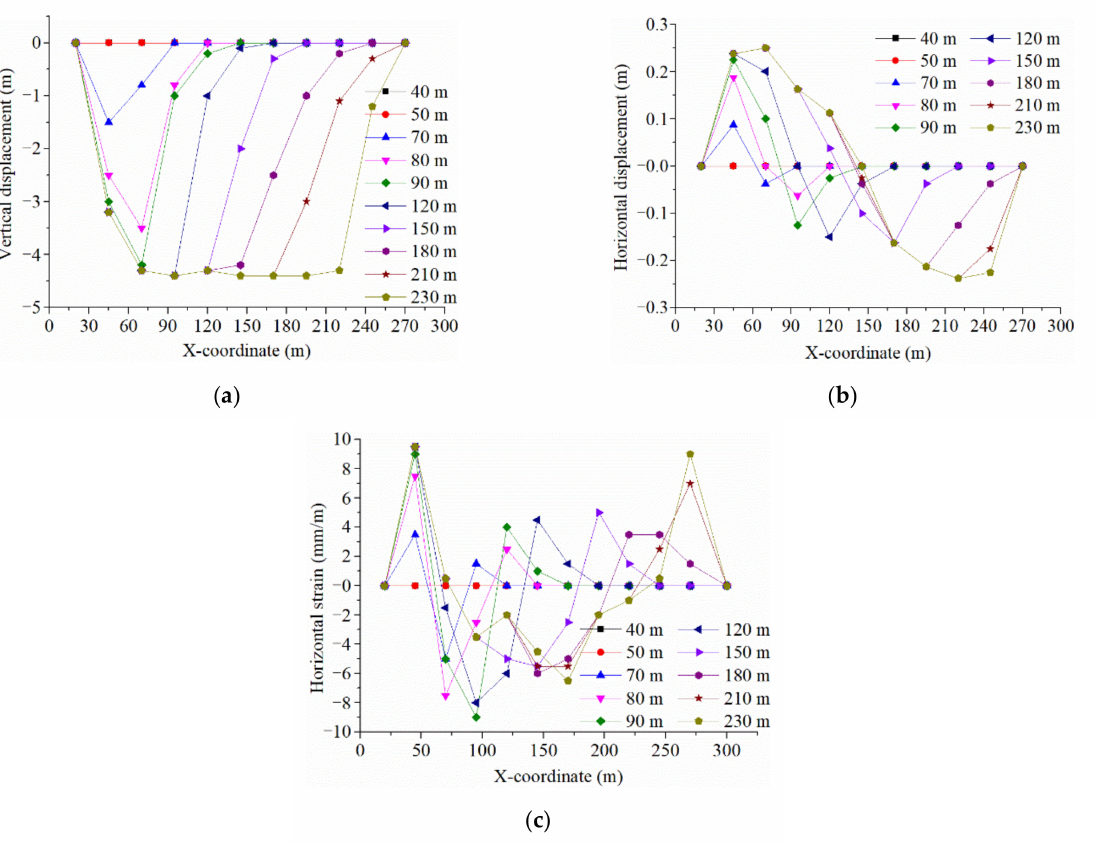
Figure 6. Aquiclude displacement during panel extraction: ( a ) vertical displacement; ( b ) horizontal displacement; ( c ) horizontal